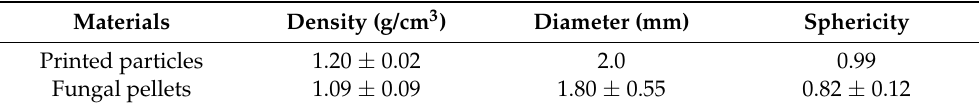
Figure 2. Images showing the different morphology of ( a ) 3D ‐ printed particles and ( b ) fungal pellets.